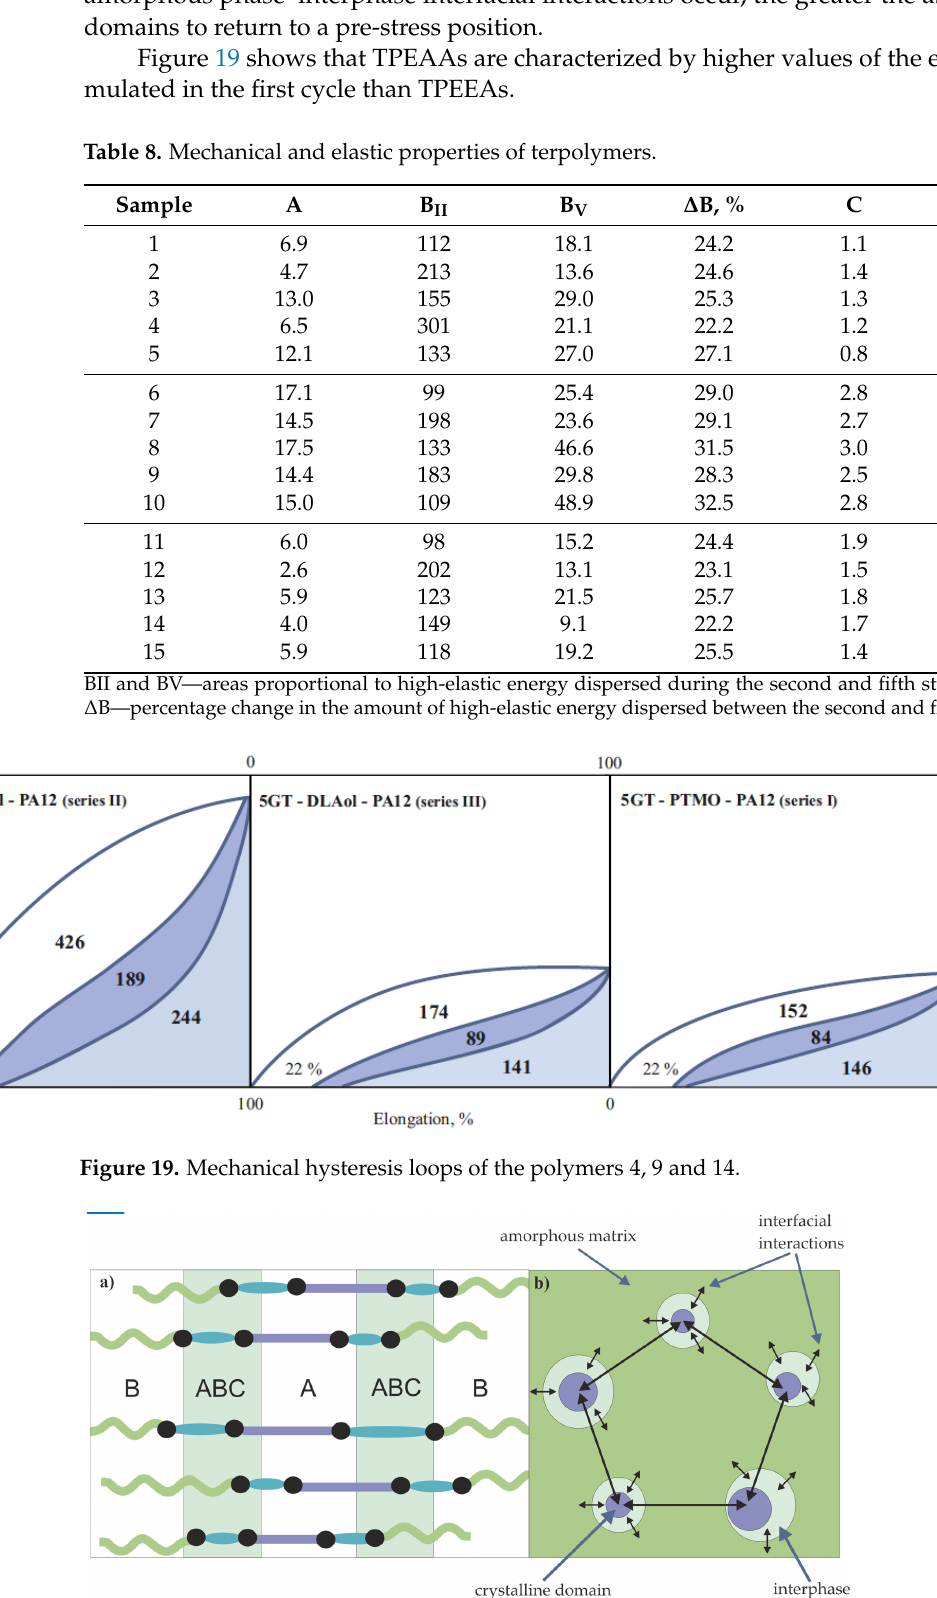
Table 8. Mechanical and elastic properties of terpolymers.